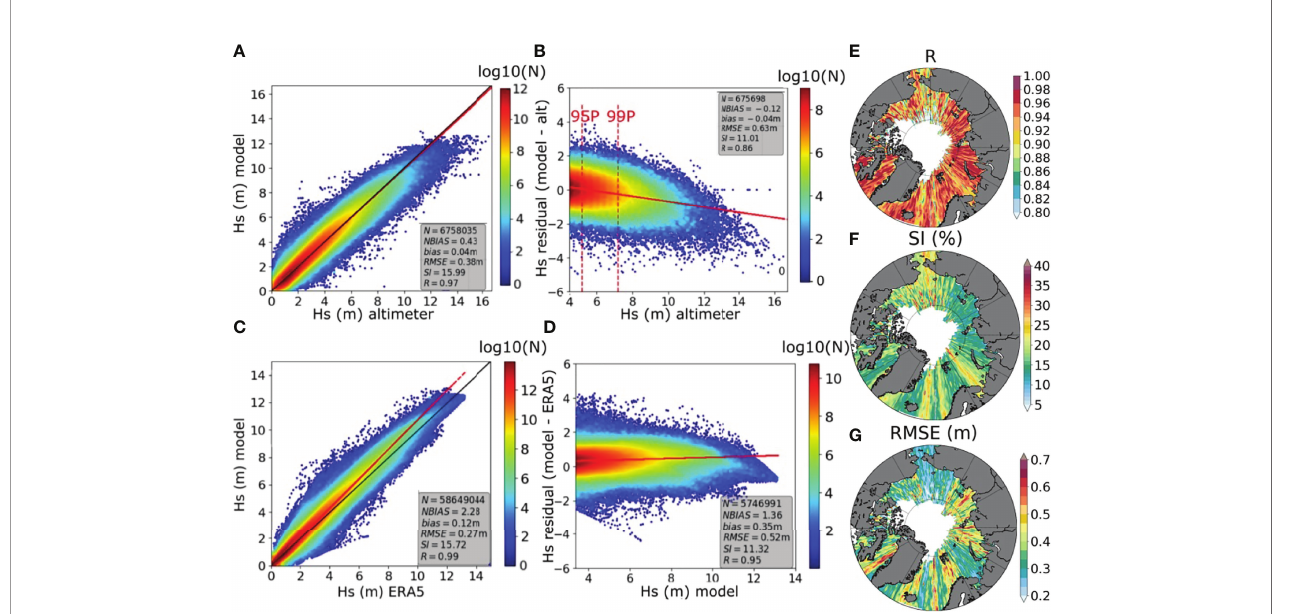
FIGURE 2 | Validation of signi fi cant wave height for the period 2012 – 2016 with ST6 core physics. Comparison against altimeter observations: (A) all data and (B) 90th percentile. Comparison against ERA reanalysis: (C) all data and (D) 90th percentile and above. The black line represents the 1:1 agreement and the red lines are the linear regression. Regional distribution of error metrics (in relation to altimeter observations and data in the 90th percentile): (E) correlation, (F) scatter index, and (G) root mean square